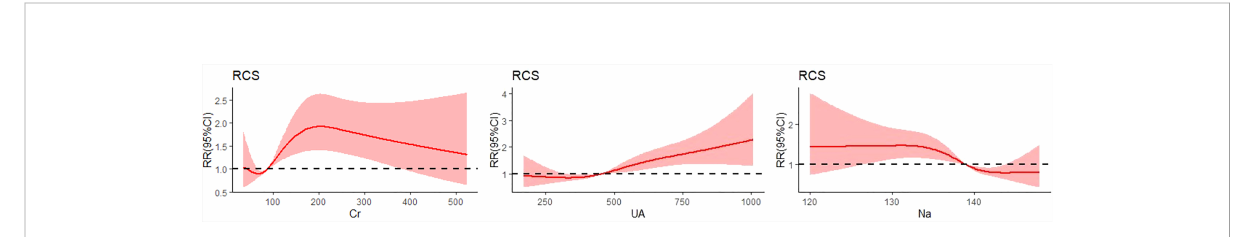
FIGURE 8 Restricted cubic spline plot of the relationship between readmission and in fl uencing factors in heart failure patients within 3